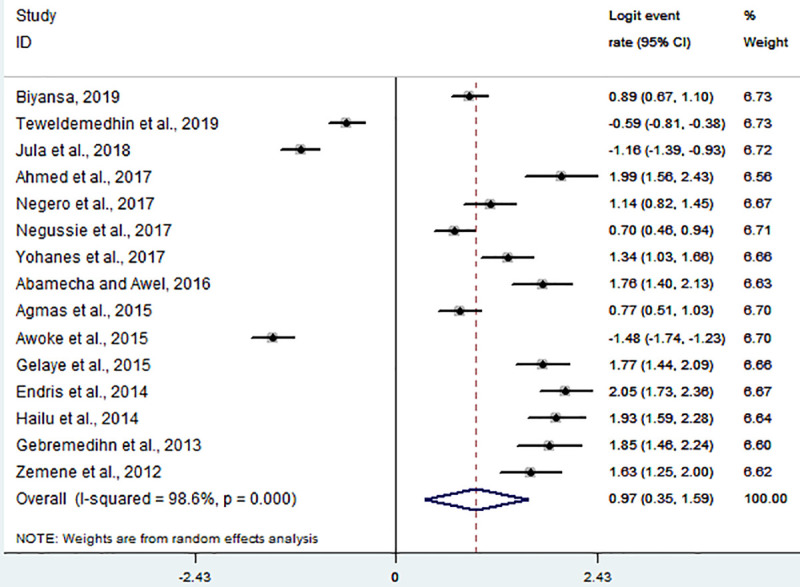
Forest plot of the logit event rate estimate (lp) in pregnant women.